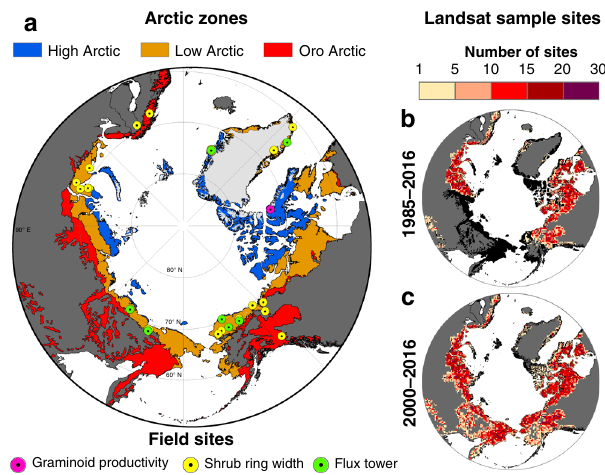
Fig. 1 Spatial extent of Arctic tundra and locations of fi eld and Landsat sample sites. a The Arctic can be subdivided into the minimally vegetated High Arctic, moderately vegetated Low Arctic, and southern mountainous Oro Arctic. Landsat NDVI max was compared against three metrics of plant productivity measured at fi eld sites around the Arctic. b , c Number of Landsat sampling sites within a 50 × 50 km 2 grid cell that were used for assessing NDVI max trends and correlations with summer temperatures from 1985 to 2016 and 2000 to 2016. It was not possible to assess NDVI max trends or correlations in the eastern Eurasian Arctic from 1985 to 2016 owing to the lack of Landsat data prior to circa 2000. Arctic tundra without adequate data for Landsat assessment is shown in black. Projection: Lambert Azimuthal Equal